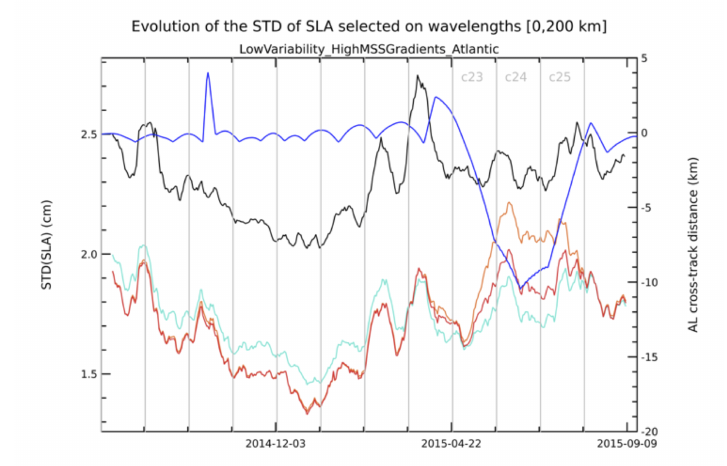
Figure 3. Temporal evolution of the standard deviation of the SLA, along Jason-2 tracks (calculated with respect to its alongtrack precise MSS in black) and along SARAL/AltiKa tracks (calculated with respect to different gridded MSS products: MSS CNES_CLS15 (in red), CNES_CLS11 (in orange) and DTU15 (in cyan). The SLA was high-pass filtered to keep only wavelengths shorter than 200 km. Statistics are computed over a low variability and intense bathymetric gradients region in the northeast Atlantic [20 ◦ S, 0 ◦ N; 30 ◦ W, 0 ◦ E]. The blue line shows the cross-track distance (in km; right axis) of the SARAL/AltiKa tracks compared to their long-term repeat groundtrack; this distance increases sharply during cycles C23, C24, and C25, marked in gray from 22 April 2015